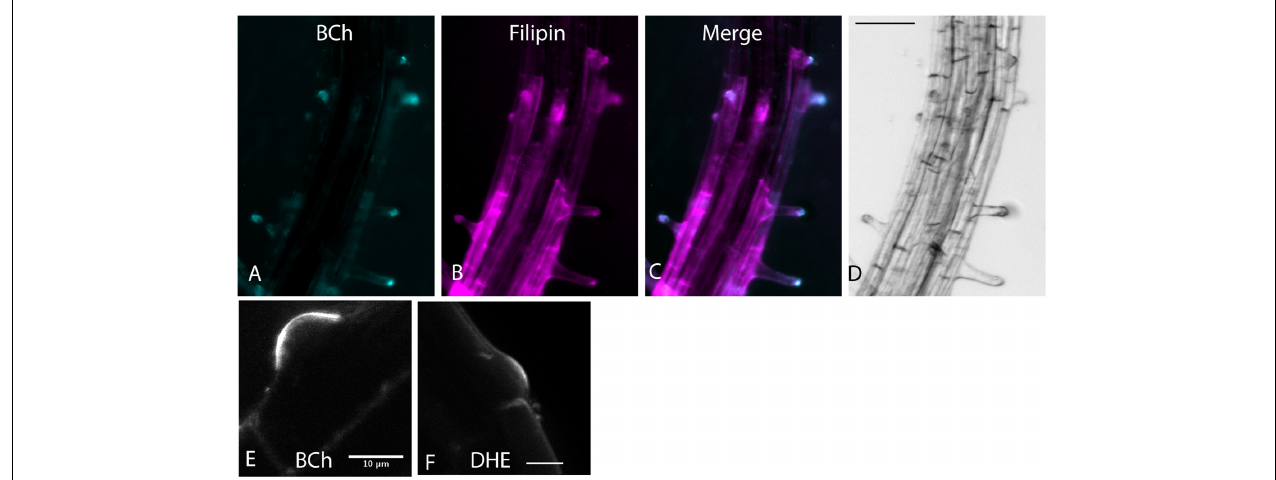
FIGURE 1 | Root hair tip localization of BCh, filipin, and DHE in 5-day-old Arabidopsis seedlings labeled for 60 min with both dyes and 30 µ M M β CD. (A) 10 µ M BCh localization primarily in the tips of the root hairs. (B) 15 µ M filipin labeling of root hair tips and along the PM of epidermal cells in the mature regions of the root. (C) Merged image of (A and B) . (D) Bright-field image of the root. Scale bar = 100 µ m. (E) Emergent root hair labeled with BCh for 20 min, similar to that shown in the upper part of A . Scale bar = 10 µ m. (F) Emergent root hair at the base of an epidermal cell labeled for 20 min with DHE. Scale bar = 10 µ m.